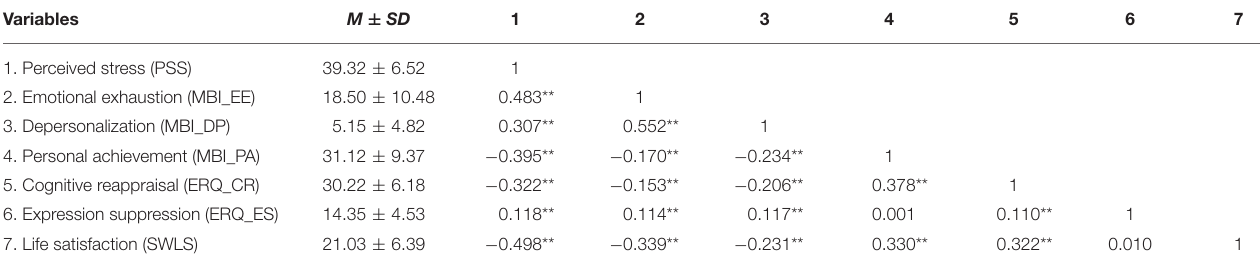
TABLE 1 | Descriptive statistics and bivariate correlations of the major study variables ( n = 1,372). Variables M ±